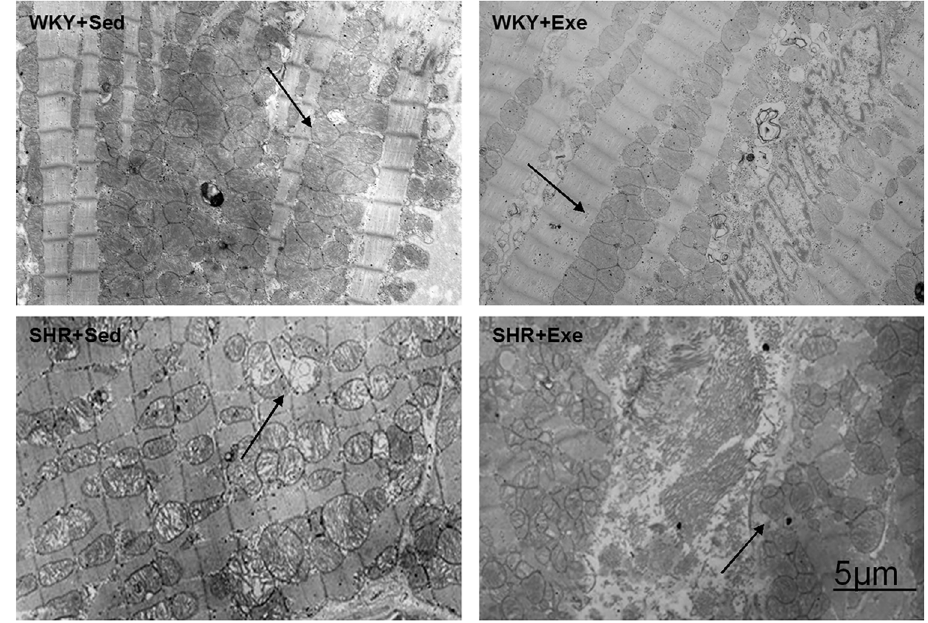
Figure 2. Moderate-intensity exercise (MIE) ameliorated damage to myocardial mitochondrial morphology in spontaneously hypertensive rats (SHRs). Cardiac mitochondrial structure was observed in Wistar-Kyoto rats sedentary or exercised (WKY + Sed, WKY + Exe), and SHR + Sed and SHR + Exe groups after 16 weeks of MIE by scanning electron microscopy. Arrows: myocardial mitochondria. Scale bar: 5 m